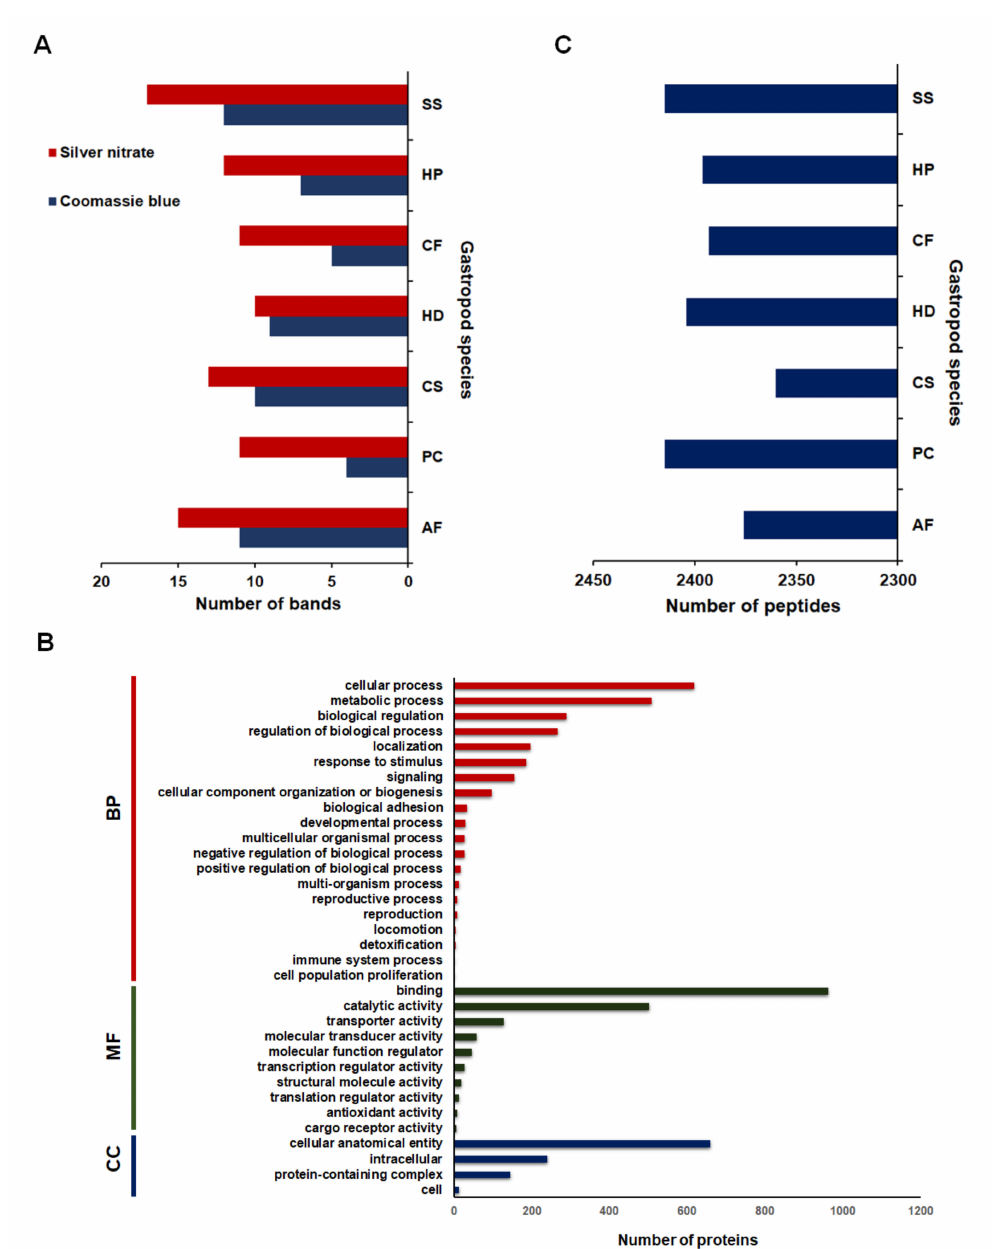
Figure 2. Comparative proteomes and peptides of mucus from seven gastropod species. ( A ) Number of protein bands of the mucus proteins from seven gastropod species separated by 1D-SDS-PAGE and stained by Coomassie brilliant blue (blue) and silver nitrate (red) as counted by the GelAnalyzer program. The number of protein bands is shown on the x -axis. The gastropod species are shown on the y -axis. ( B ) Functional annotation terms of the mucus proteome in three Gene Ontology categories ( y -axis) biological process (BP), molecular function (MF), and cellular component (CC). The x -axis represents the number of proteins. ( C ) The number of different peptides identified in the mucus of seven gastropod species. These peptide data were obtained from the mass spectrometric analysis. The number of peptides is shown on the x -axis. AF = Achatina fulica ; PC = Pomacea canaliculata ; CS = Cryptozona siamensis ; SS = Semperula siamensis ; HD = Hemiplecta distincta ; CF = Cyclophorus fulguratus ; and HP = Helix pomatia